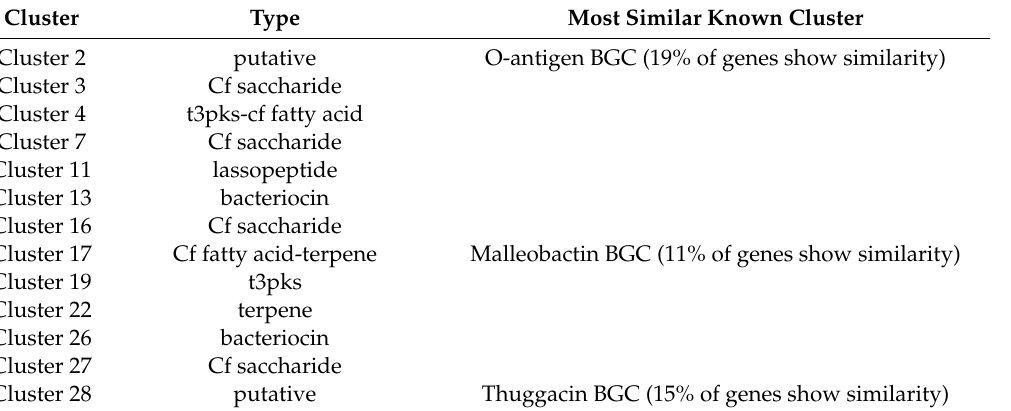
Table 4. Biosynthetic gene clusters reveled by analysis with